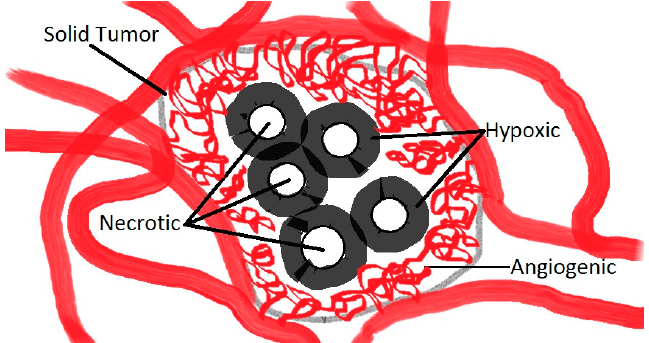
Figure 1. Simple schematic representing the main microenvironments of a solid tumor. Blood flow becomes negligible at the hypoxic-angiogenic transition due to the tumor interstitial fluid pressure (TIFP) which constitutes a barrier to the diffusion of conventional therapeutic agents towards the hypoxic regions. Oxygen concentration is maximal at the hypoxic-angiogenic transition and decreases gradually to zero (anoxic) past the hypoxic-necrotic boundaries.